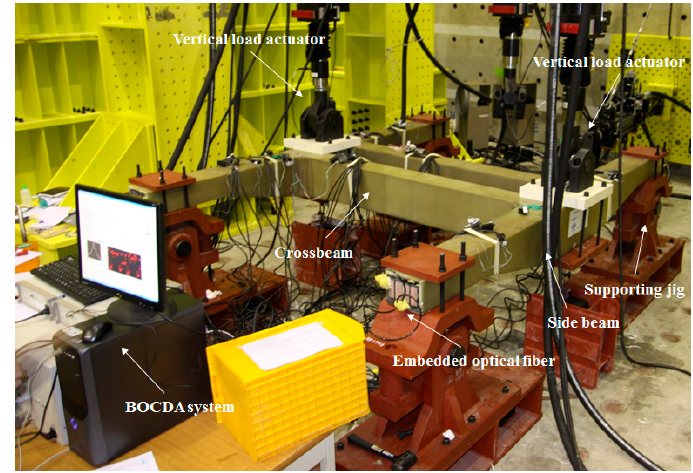
Figure 9. Equipment for the vertical train load test of a composite bogie frame.